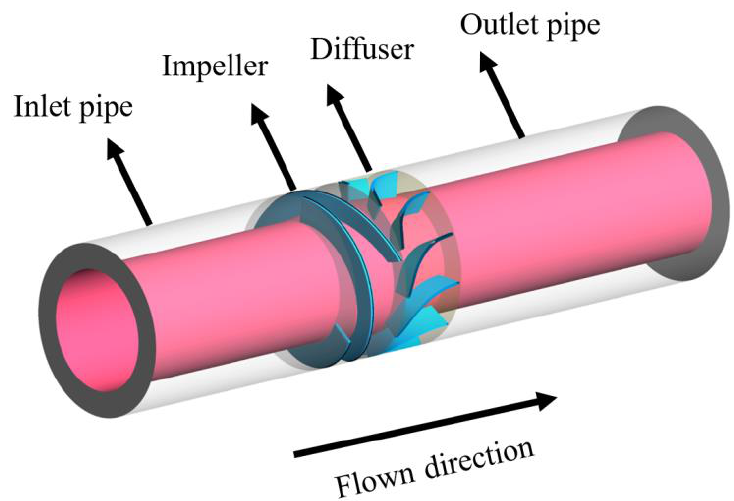
Figure 1. Computing domain.